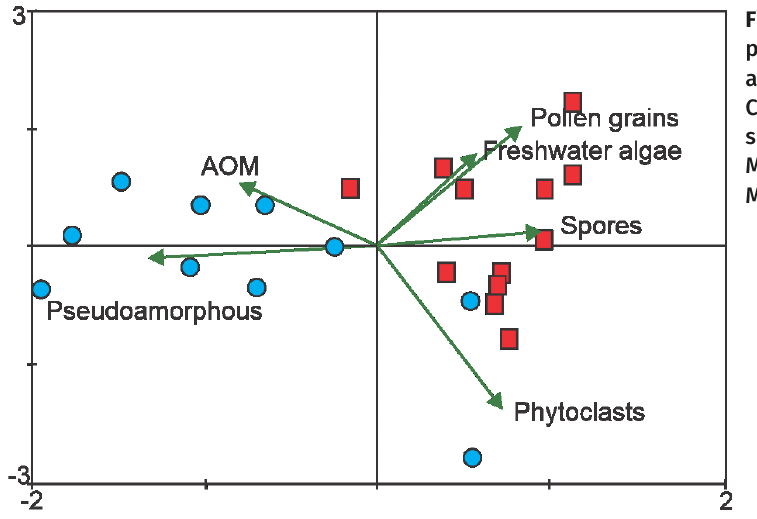
Figure 8. PCA Biplot scatter plot for palynofacies and samples from the Cerro Negro Formation. In squares (samples M.1 to M.14), and circles (samples M.15 to